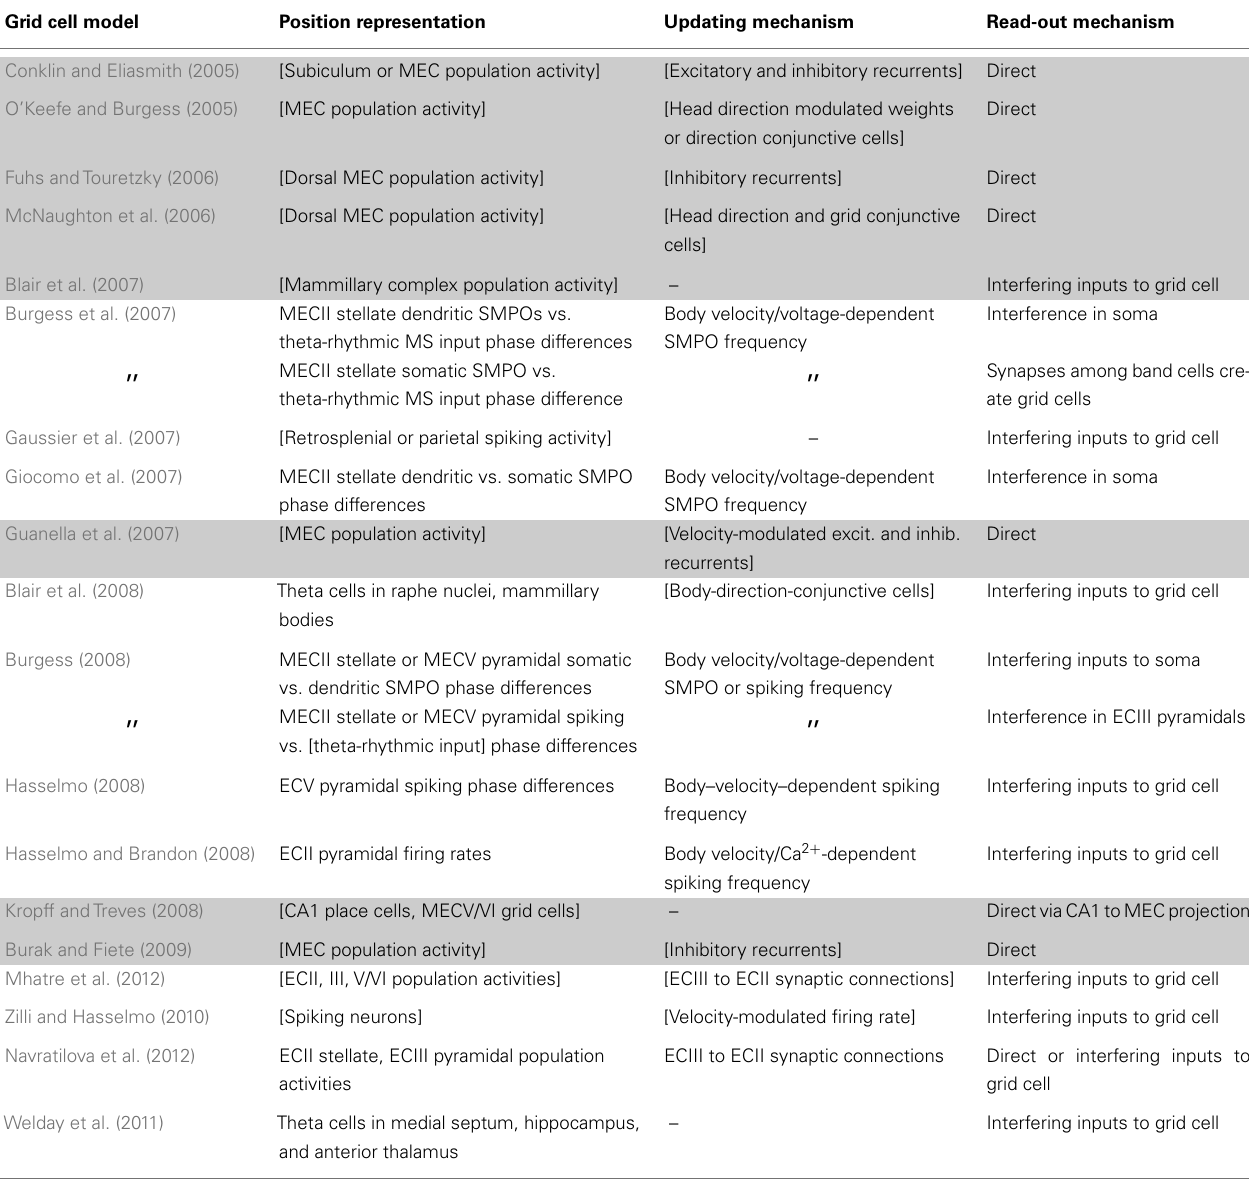
Table 2 |The models’ biological implementations, though somewhat arbitrary, allow for concrete experimental